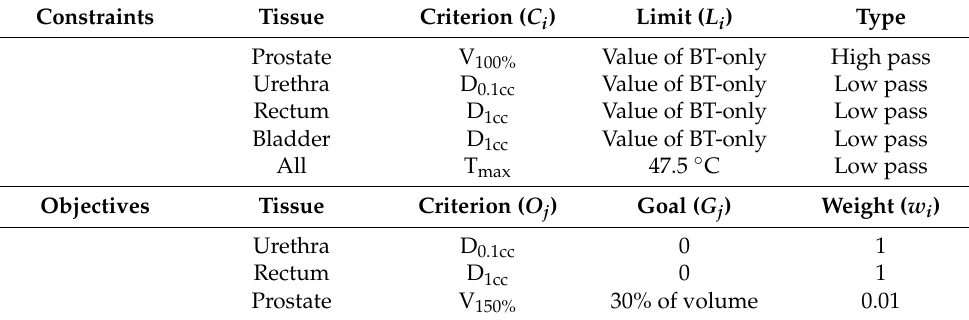
Table 4. Constraints and objectives applied in the objective function.